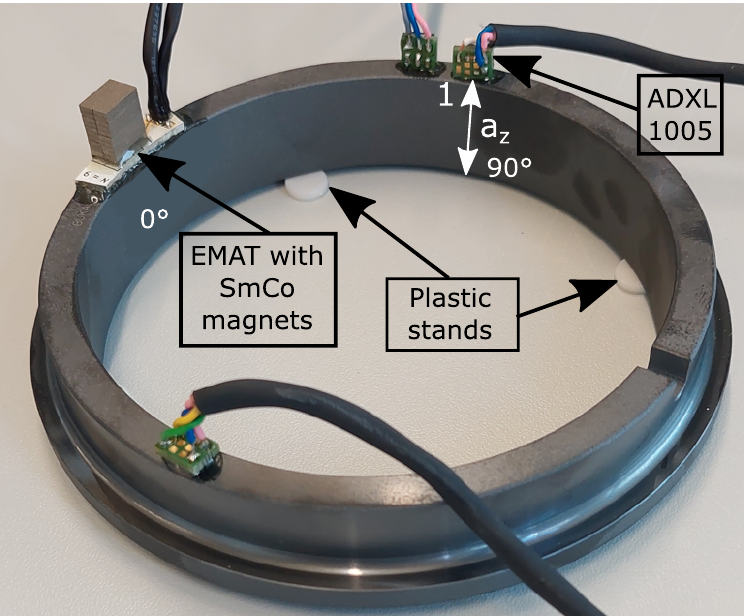
Figure 11. Experimental setup for the metrological evaluation of the mode excitation. The EMAT, with its SmCo magnets, was glued on top of the ring at the 0 ◦ spot and generated a continuous oscillation within the SiSiC ring. The ADXL 1005 was sensitive in the z-direction and measured the acceleration at the 90 ◦ position. The remaining two accelerometers were not used in this